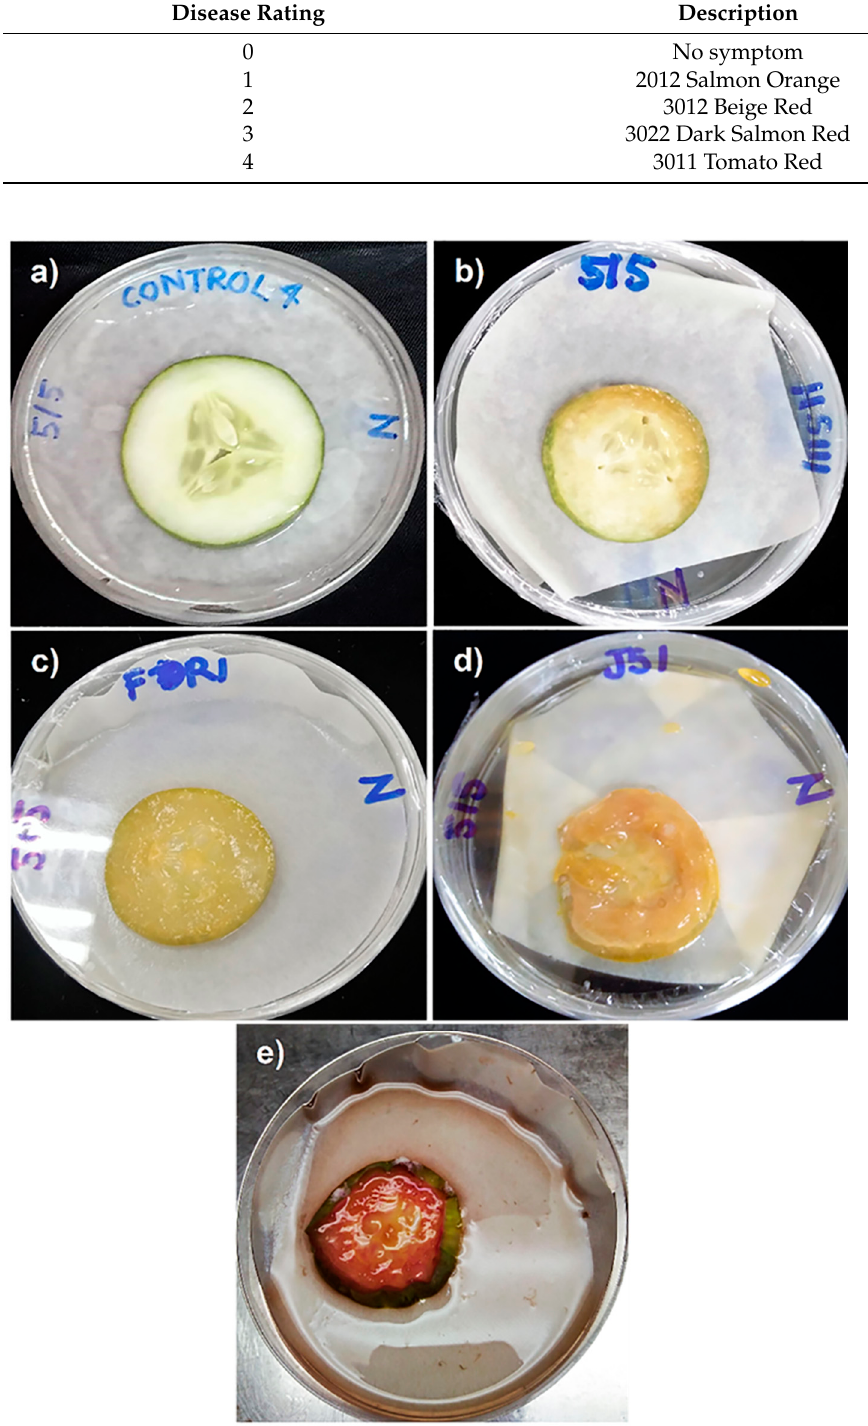
Figure 4. The disease rating of reddish discoloration of the cucumber fruitlet (rating 0–4). ( a ) Disease rating 0; ( b ) disease rating 1; ( c ) disease rating 2; ( d ) disease rating 3; ( e ) disease rating 4.